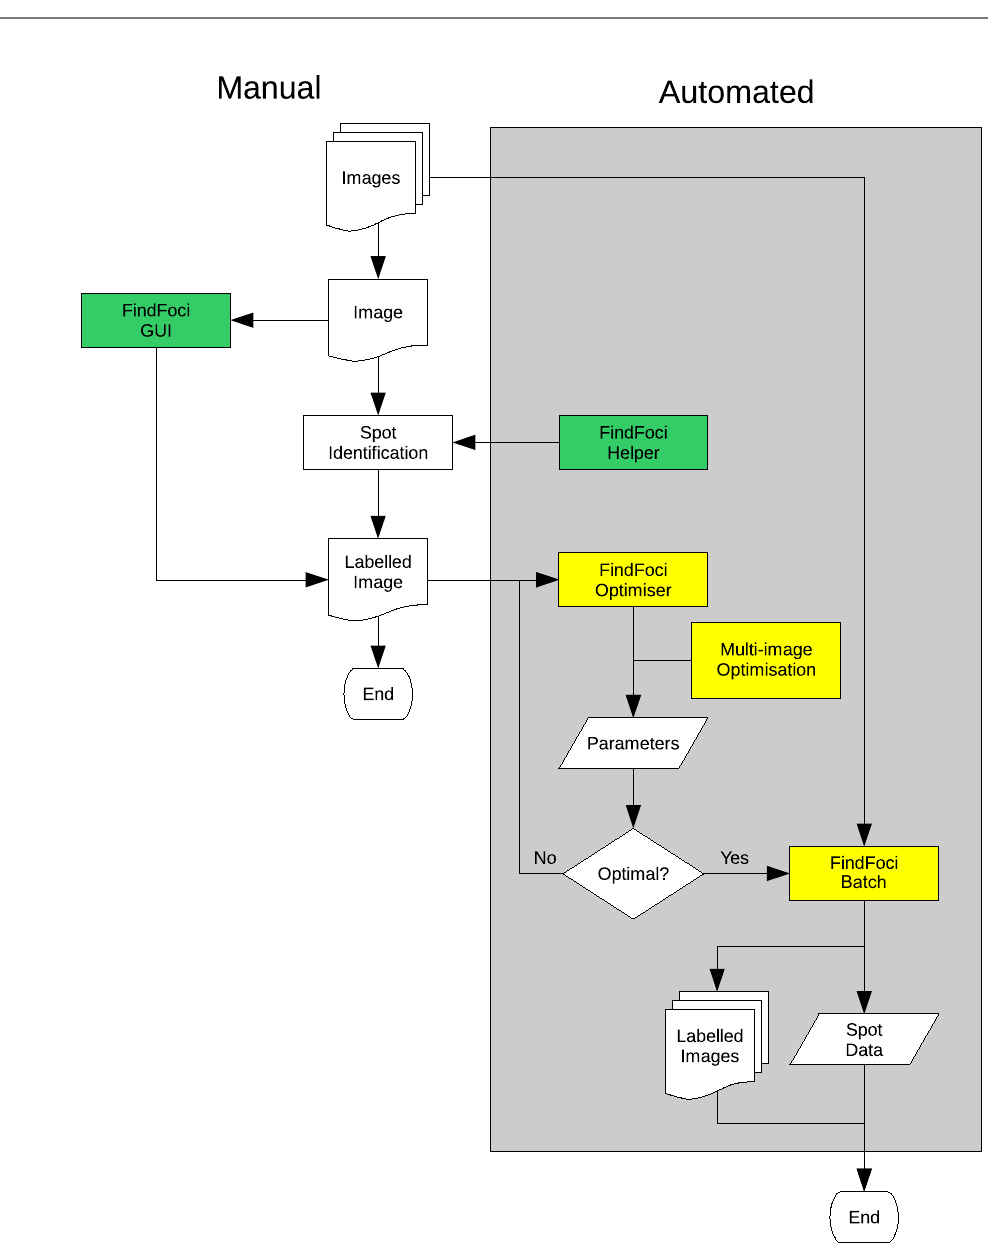
Figure 9. Flow chart of the automated workflow provided by the FindFoci software. Interactive tools are shown in green; automated scriptable tools are shown in yellow. After images have been collected, manual assignment of foci can be improved by the FindFoci Helper, which aligns clicked points to their true maximum. The FindFoci Optimiser can then be trained on the resulting labelled image to identify the best parameters for the algorithm. The FindFoci GUI provides a real-time update of the results while the user changes the parameters. Training on multiple images can be achieved using the Multi-Image Optimiser plugin in order to improve consistency. The number of initial images used for training is discussed in the main text. The parameters can be applied to a large set of images using the FindFoci Batch